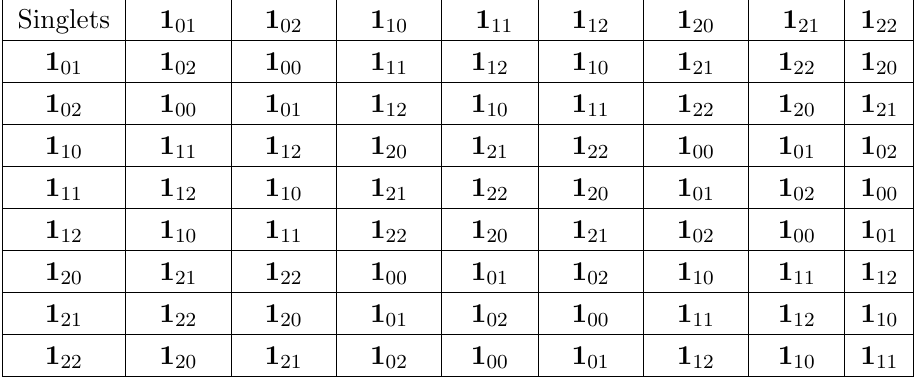
Table 6 . The singlet multiplications of the group